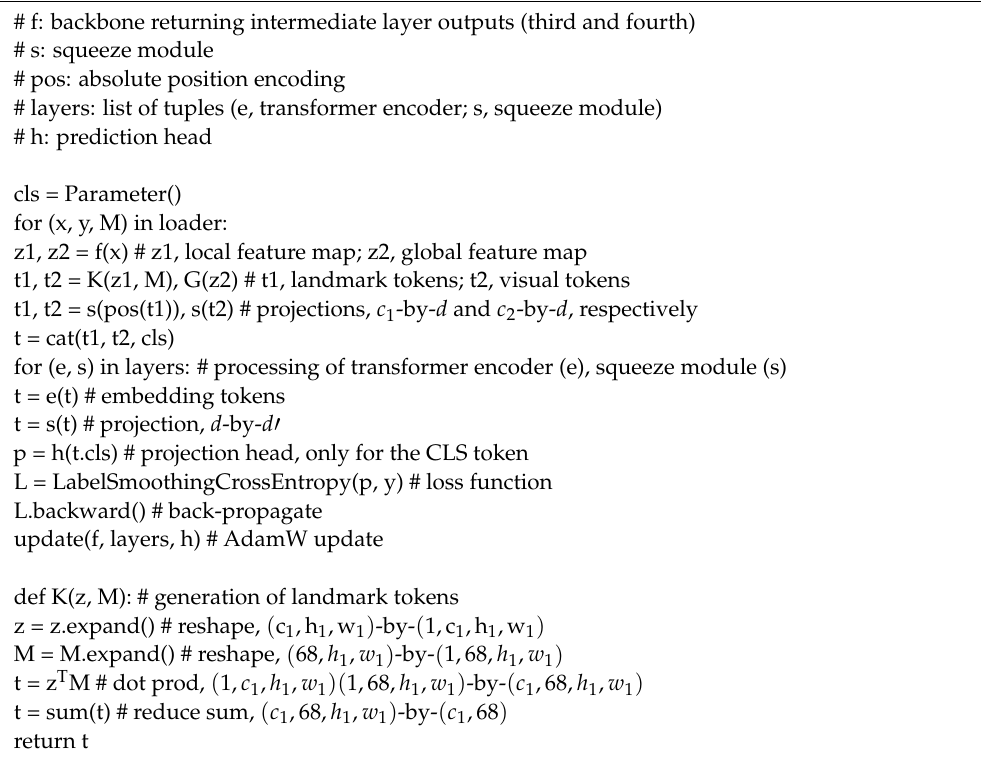
Algorithm 1: Training of Pytorch-like Squeeze ViT